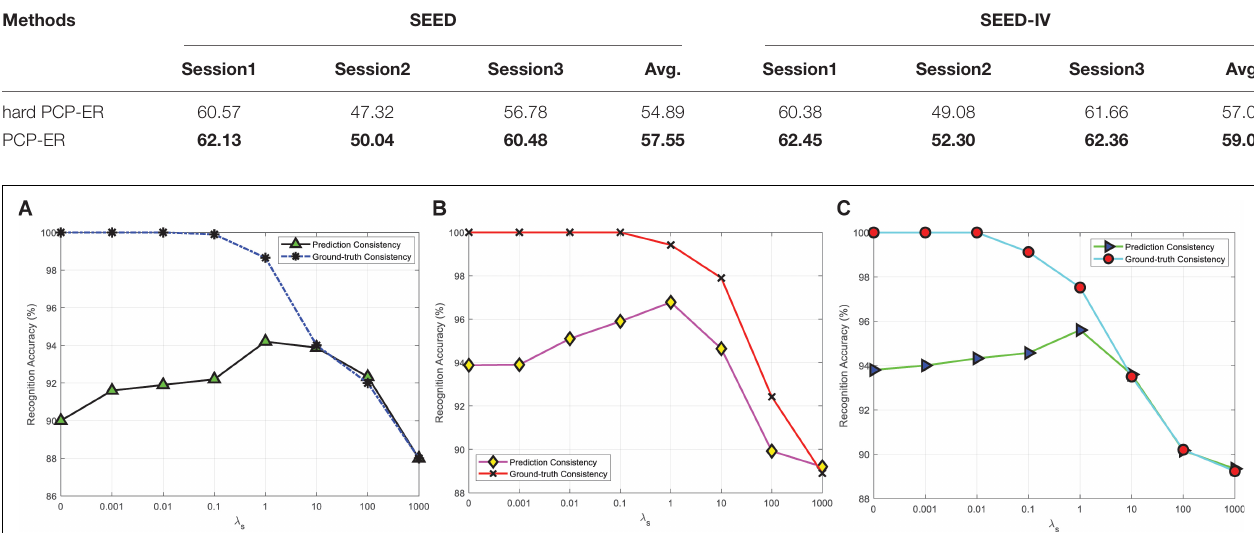
TABLE 7 | Performance comparison between hard PCP-ER and PCP-ER on SEED and SEED-IV datasets. Methods